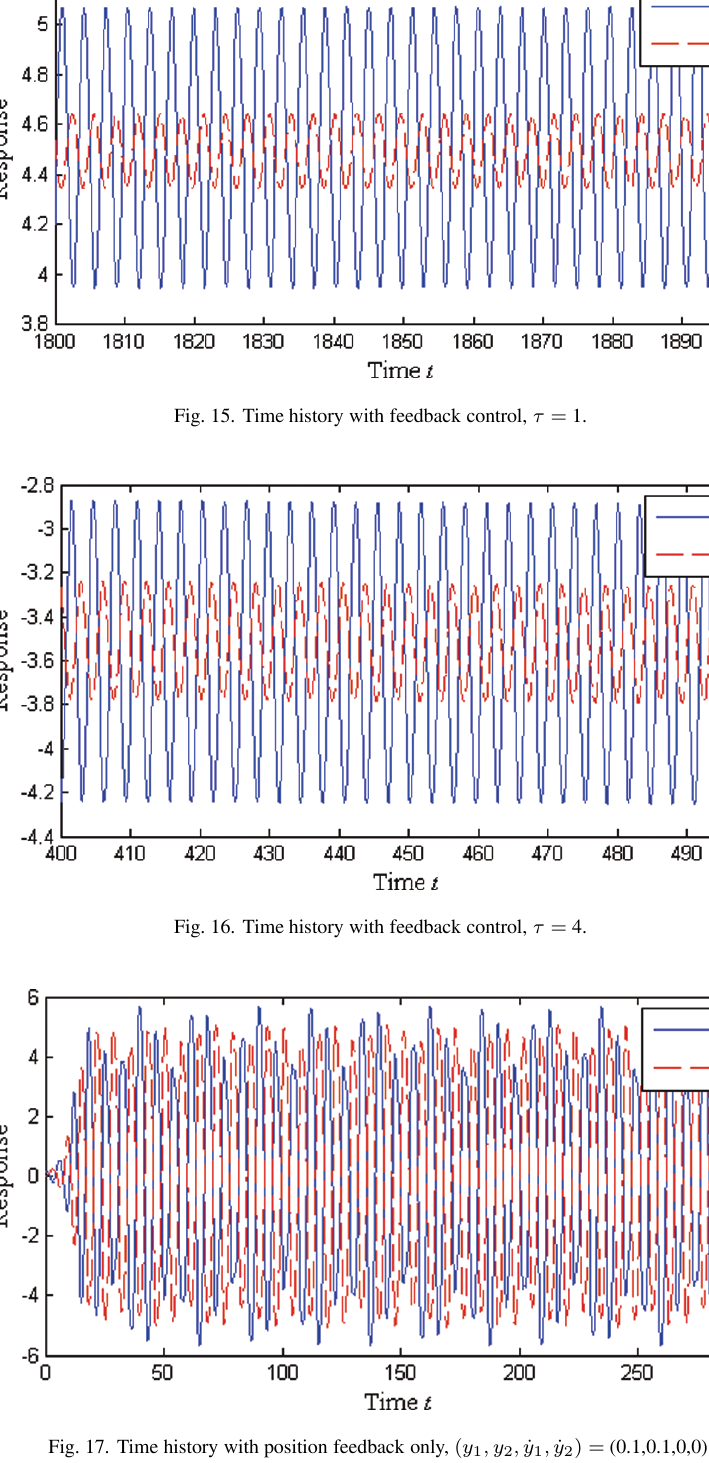
Fig. 17. Time history with position feedback only, ( y 1 ,y 2 , ˙ y 1 , ˙ y 2 ) =